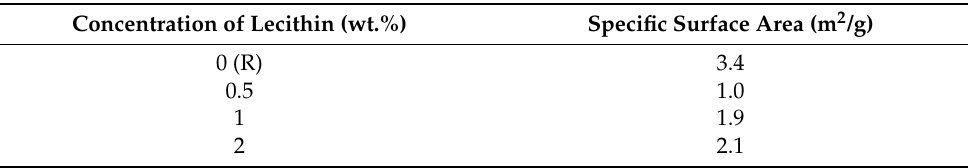
Table 3. Specific surface area for physically crosslinked agarose xerogels with the addition of lecithin determined by gas sorption.